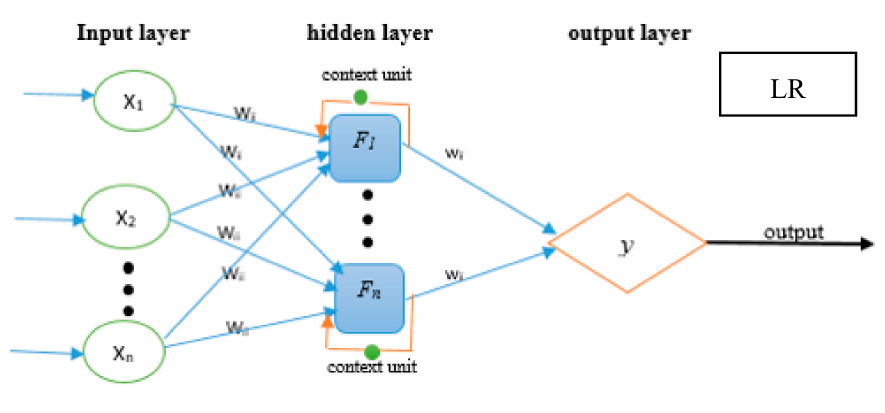
Figure 7. The NARX, FFNN and LR neural network